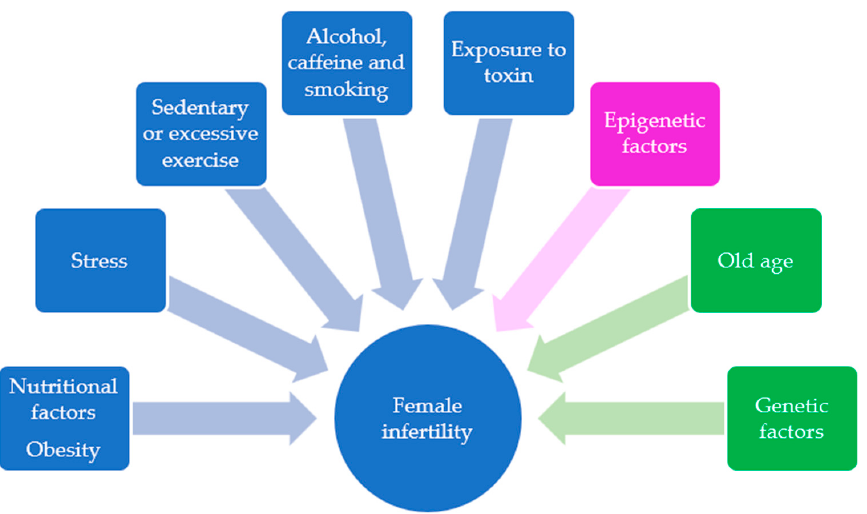
Figure 1. Schematic representation of lifestyle behaviors (blue). Epigenetic factors (purple) and non ‐ modifiable risk factors (green) that contribute to female infertility.